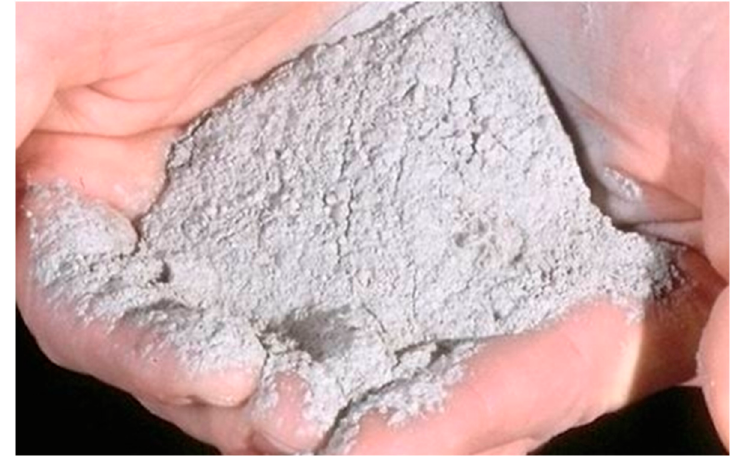
Figure 1. Carbonated recycled concrete fine.